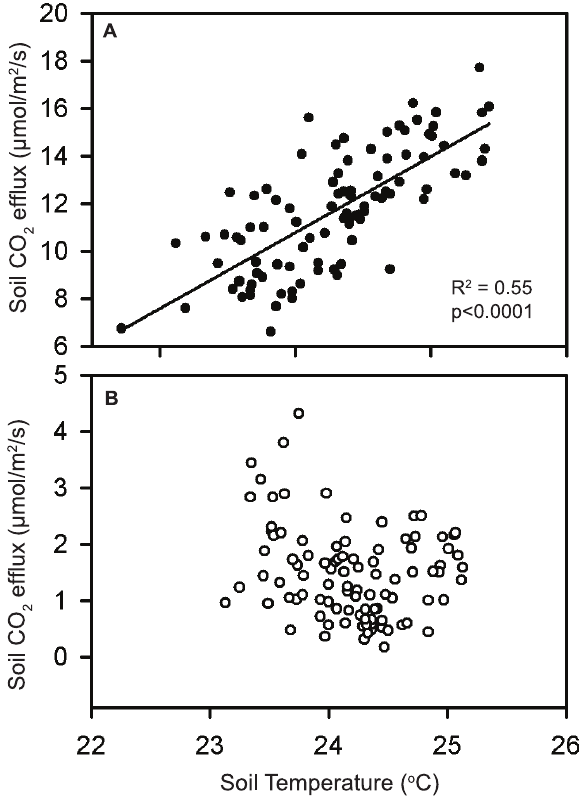
Figure 5. Regression between mean daily soil temperature and mean daily soil CO 2 efflux in the (A) control and (B) exclusion plots.